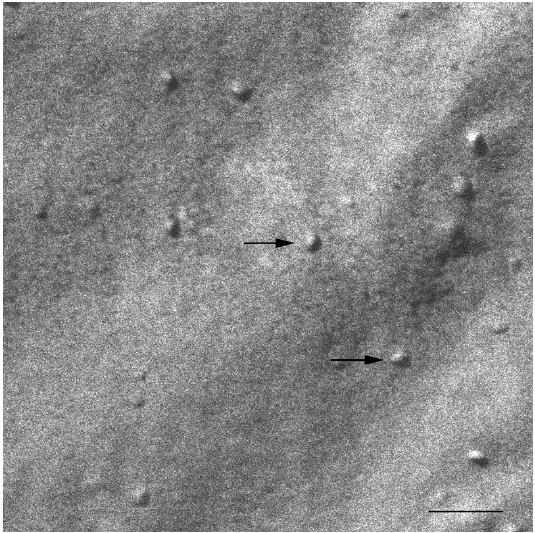
Figure 2. Electron micrograph of the S-q2 system at 20 °C. The arrows indicate the small bicelles of about 20 nm. Bar = 100 nm.